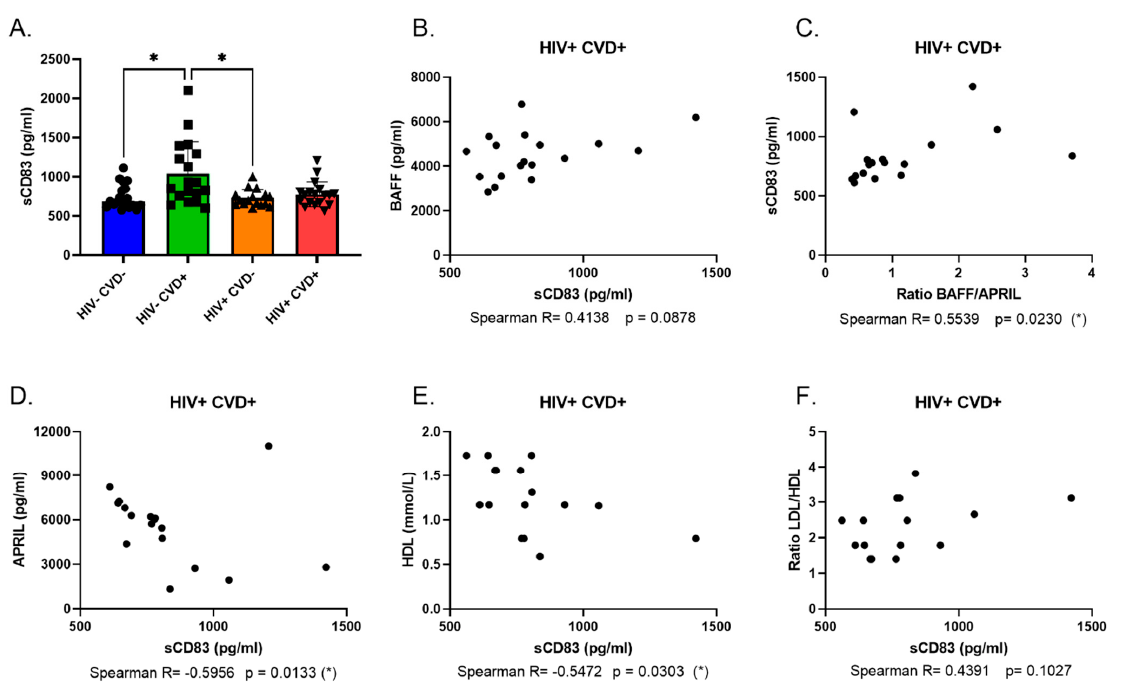
Figure 5. Soluble CD83 (sCD83) levels in the blood of individuals of the CHACS. Levels of sCD83 ( A